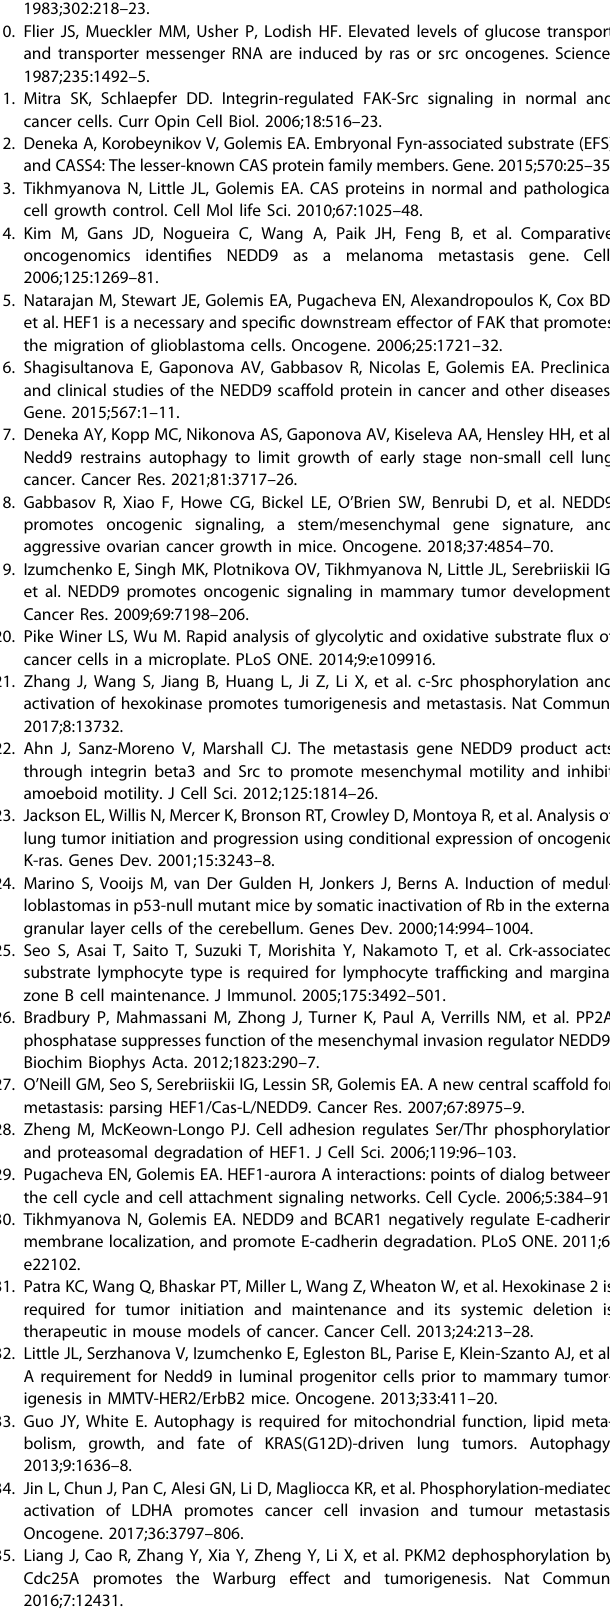
Supplementary Table S2. For each sample, the values were averaged and standard deviation of data derived from two independent PCR experi- ments representing biological